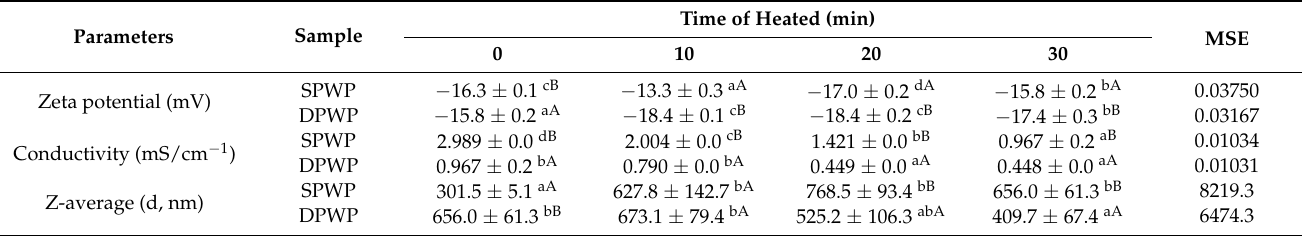
Table 1. Electrical properties and particle size of polymerized whey protein depending on the heating time.